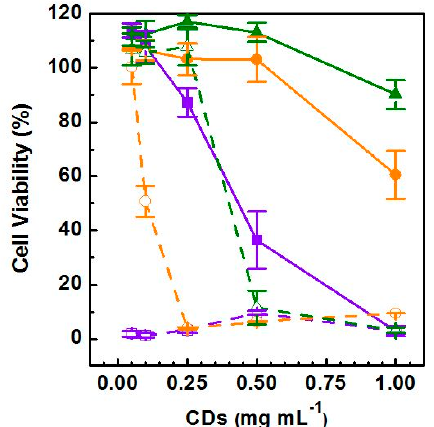
Figure 5. Cytocompatibility on breast cancer cell line (MDA-MB-231) after 48 h of incubation: CDs 18.5bar (violet solid line), CDs 13bar (orange solid line) and CDs 8bar (green solid line). Cytocompatibility after NIR-triggered photothermal treatment (810 nm, power of 5 W cm − 2 ): CDs 18.5bar (violet dash line), CDs 13bar (orange dash line) and CDs 8bar (green dash line).